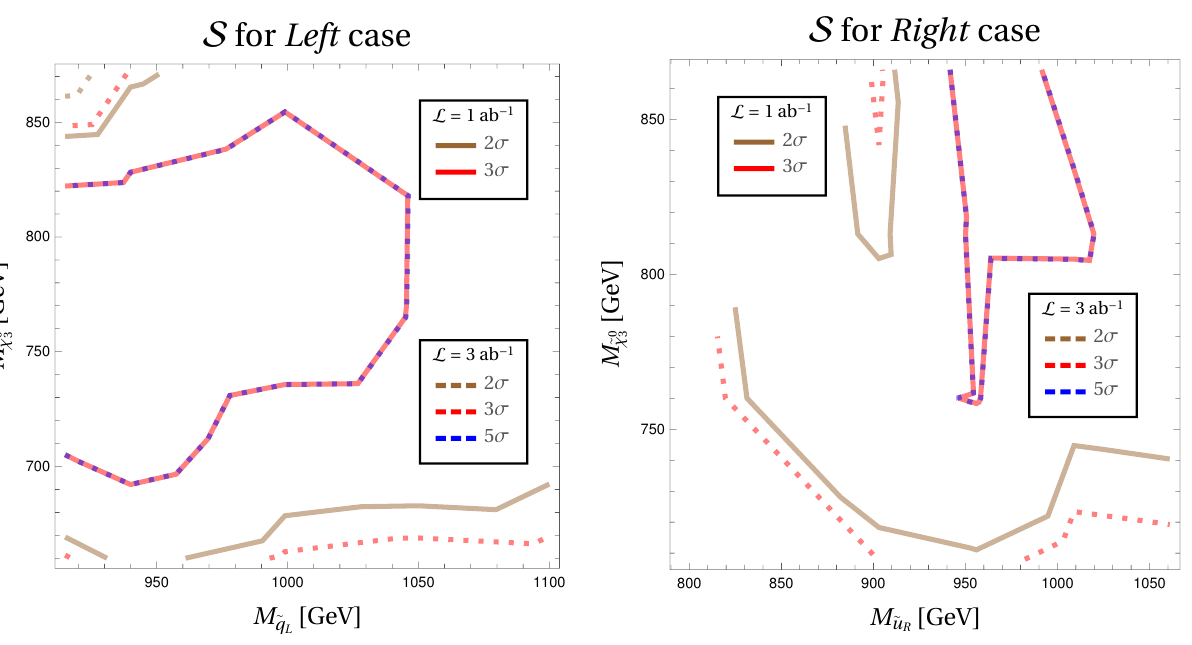
] for ˜ q L ( left ) and ˜ u R ( right ) productions. Solid (dotted) Figure 6. Contour lines in the plane [ M ˜ q , M ˜ χ 0 3 lines correspond to L = 1 (3) ab − 1 . The brown, red and blue colors are the S (background systematic uncertainty of 30%) with values of 2 σ , 3 σ and 5 σ ,